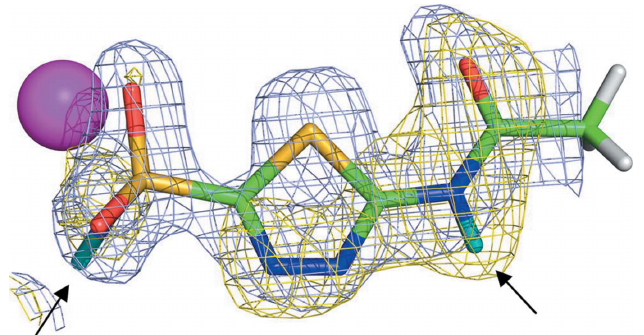
Figure 11 X-ray (gray) and nuclear (yellow) density map for the drug acetazolamide bound to human CA-II. Reprinted with permission from Fisher et al. (2012), J. Am. Chem. Soc. 134 , 14726–14729. Copyright (2012) American Chemical Society.